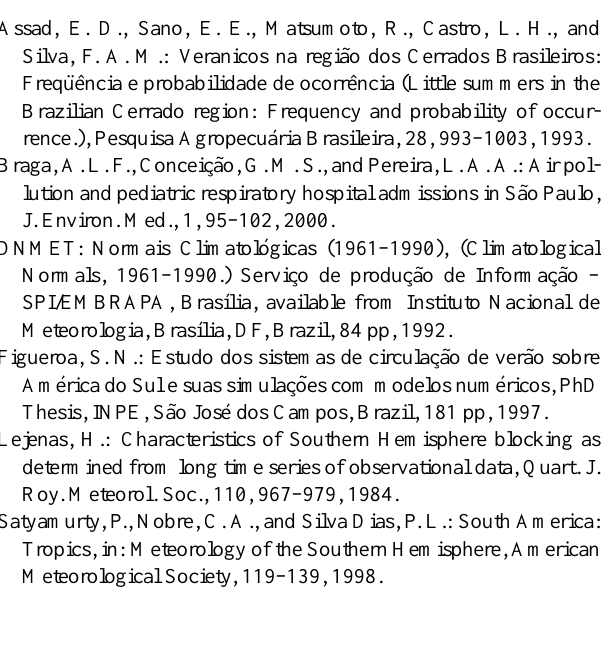
Figueroa, S. N.: Estudo dos sistemas de circulac¸˜ao de ver˜ao